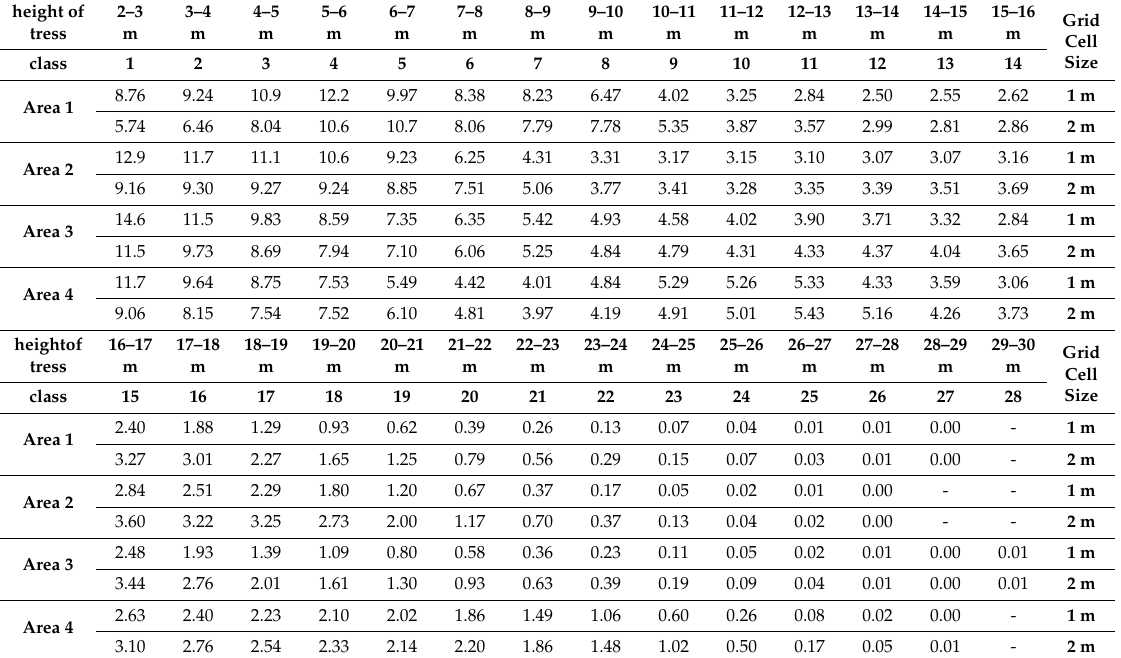
Table 4. The height structure of forest cover grown after 1966. The data in the table represent the share of individual classes in the forest cover structure. The table contains the percentage of classes for plots developed for a grid cell size of 1 m and 2 m.